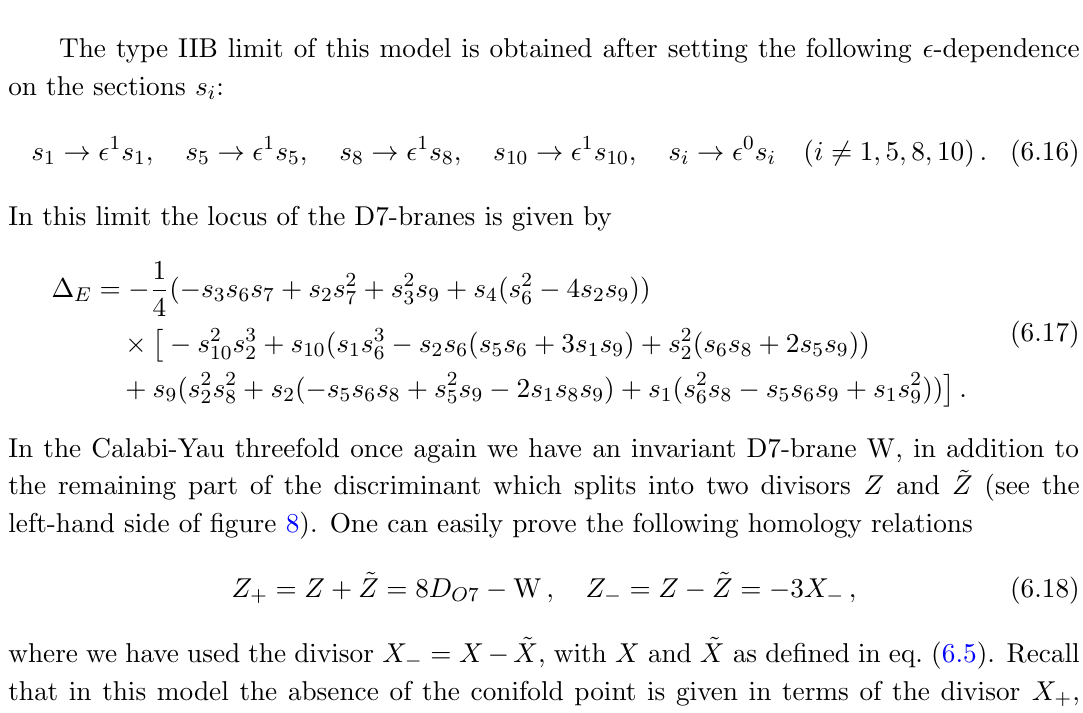
Figure 8 . The intersecting brane con(cid:12)gurations for the (cid:12)brations based on P F (right). In the limit s 10 = 0, the brane Z splits into